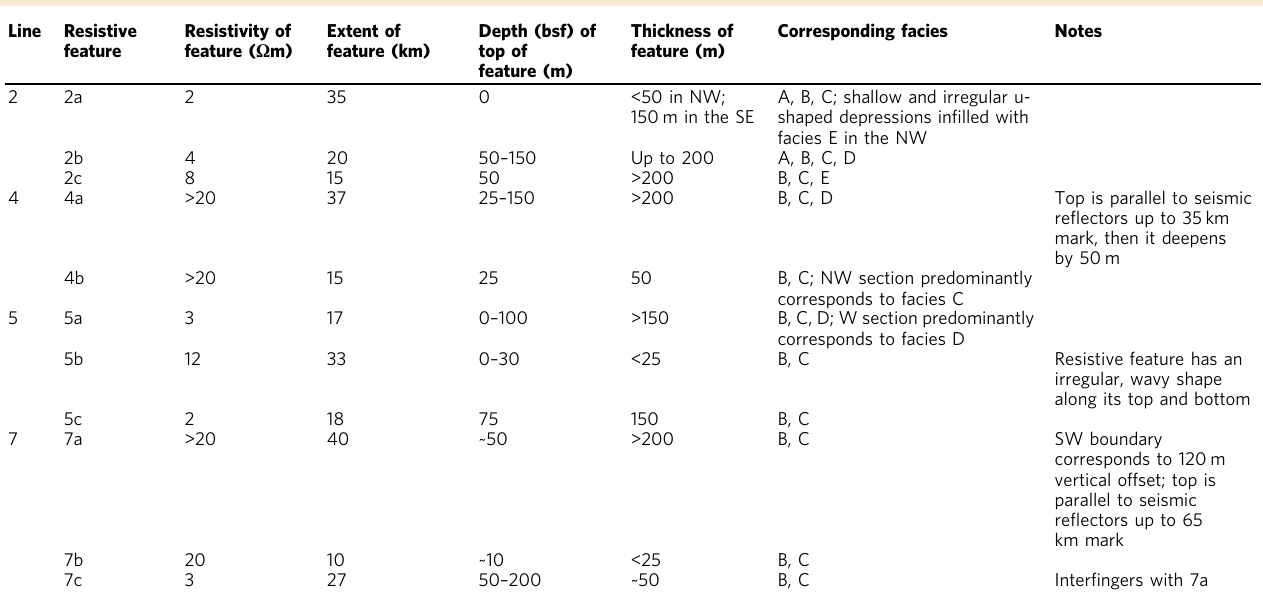
Table 1 List of resistive features identi fi ed in lines 2, 4, 5 and 7 and their properties. Line Resistive feature